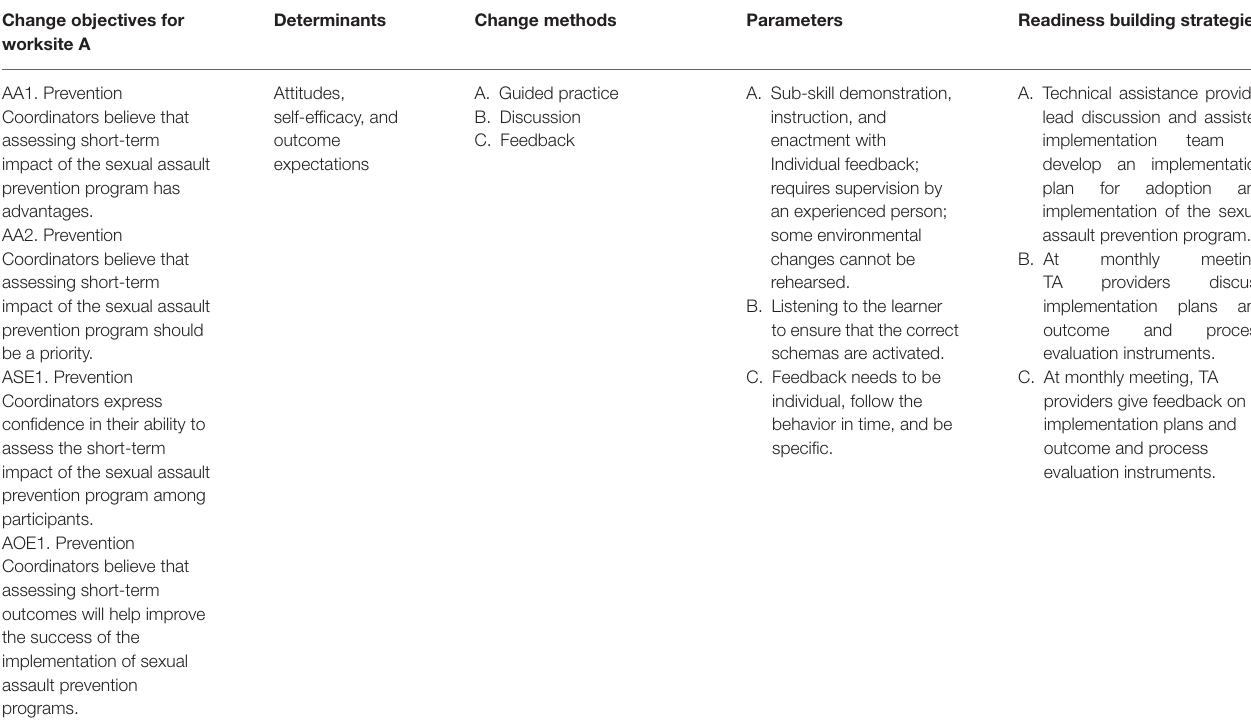
TABLE 4 | Example change methods and readiness building strategies and their associated change